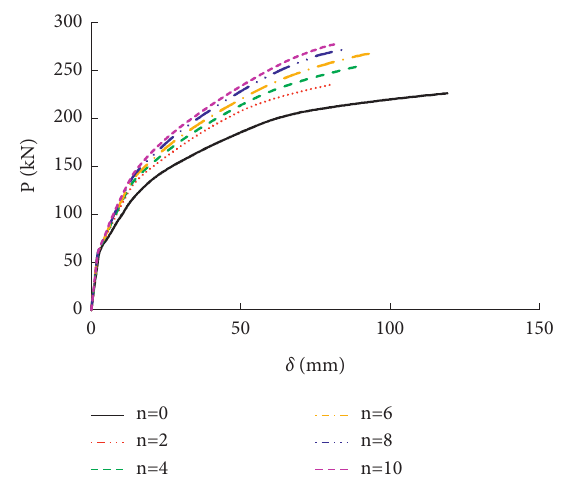
Figure 9: The load-deformation curves of different amounts of CFRP